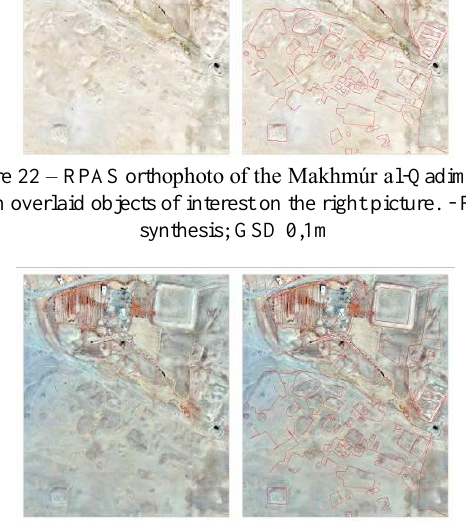
Figure 23 – RPAS orthophoto of the Makhmúr al-Qadima site with overlaid objects of interest on the right picture. NIRGB